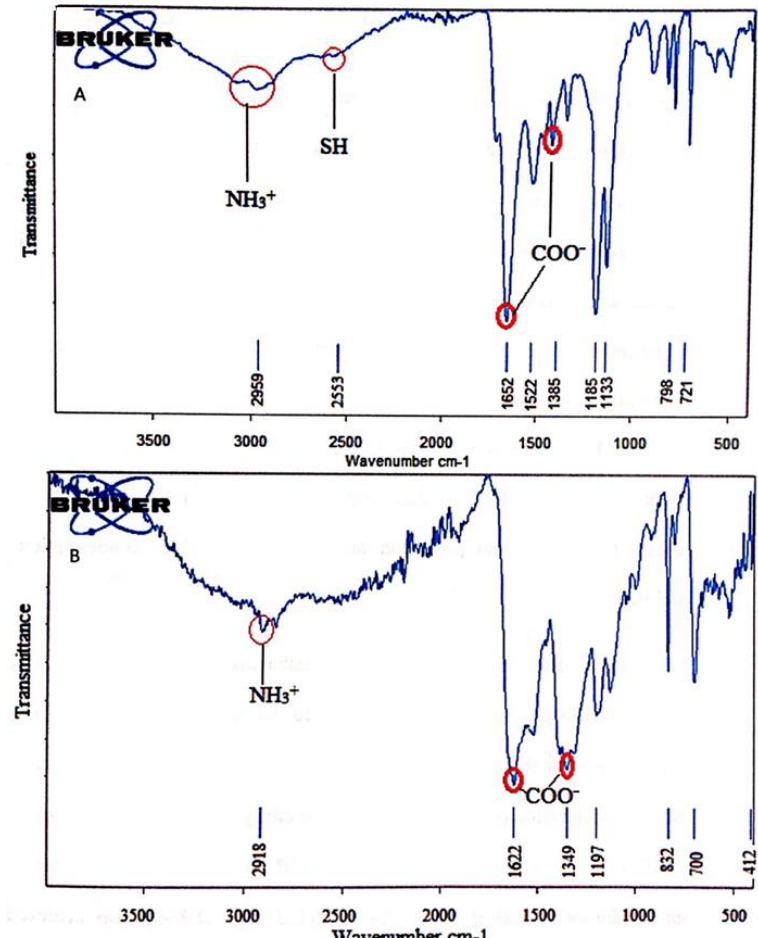
Figure 2. Infrared spectra of stabilized ligand GPDCALNNC ( A ) and GPDCALNNC-capped Au NPs ( B ). Functional ligands inside red circles represent the shift in the band position and disappearance of thiol band, suggesting the formation of a thiolate–gold bond.